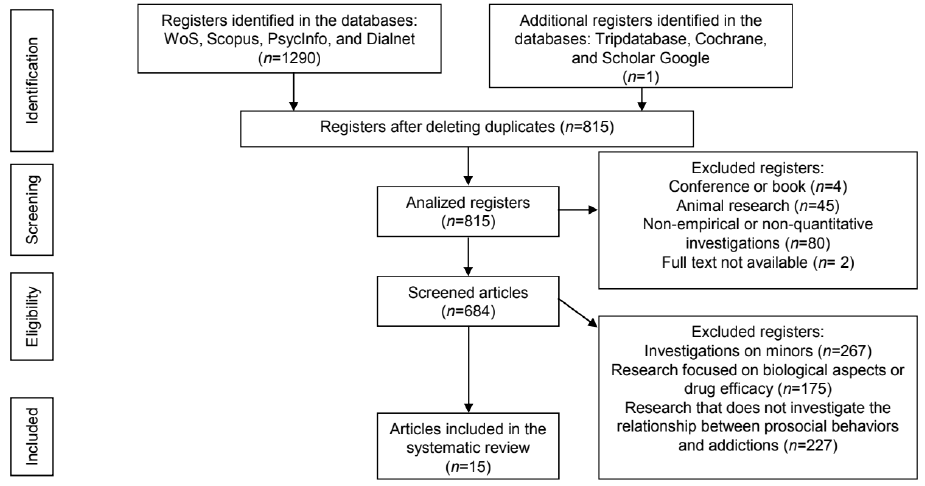
Figure 1. Flowchart of the selection and screening process of the systematic review articles accord- ing to the PRISMA method. to the PRISMA